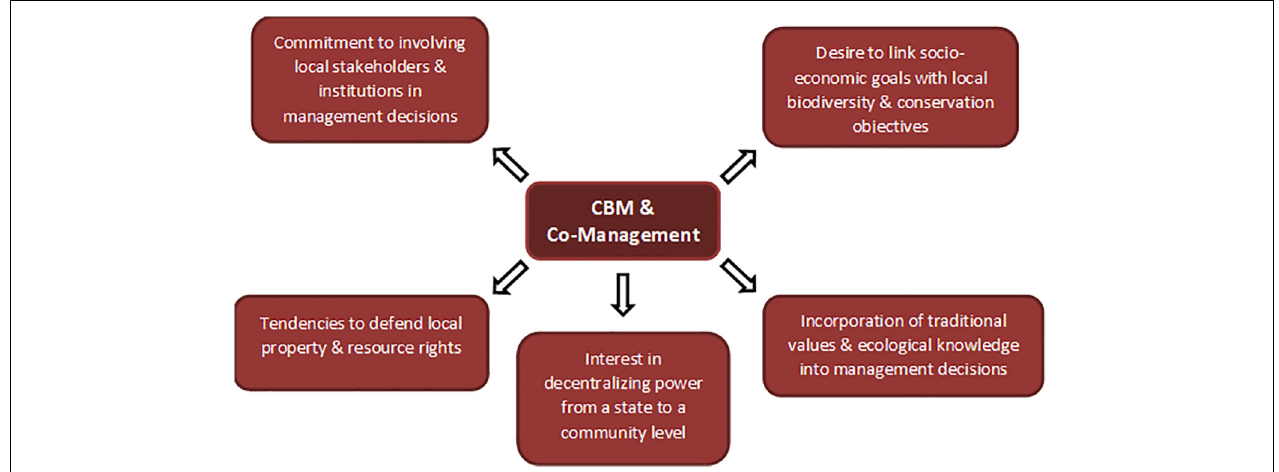
FIGURE 3 | Common hallmarks of CBM and co-management approaches (based on Fernandes,